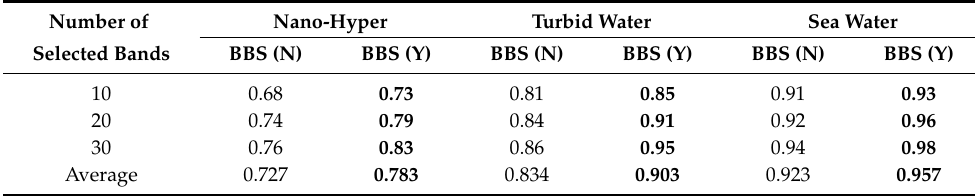
Table 3. The AUC values of the UTD results for confirming the effectiveness of IBSGS. Number of Nano-Hyper Turbid Water Sea Water Selected Bands BBS (N)